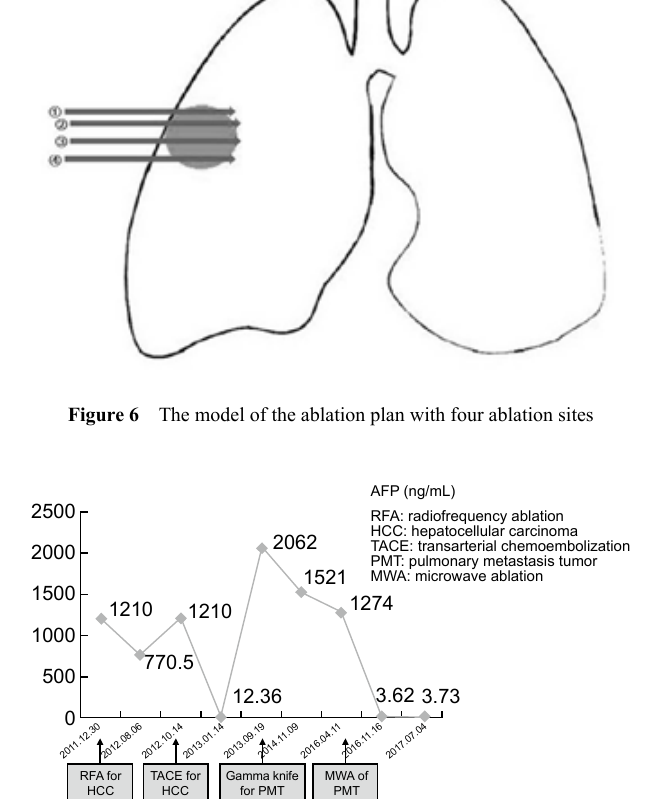
Figure 7 The flowchart of AFP changes